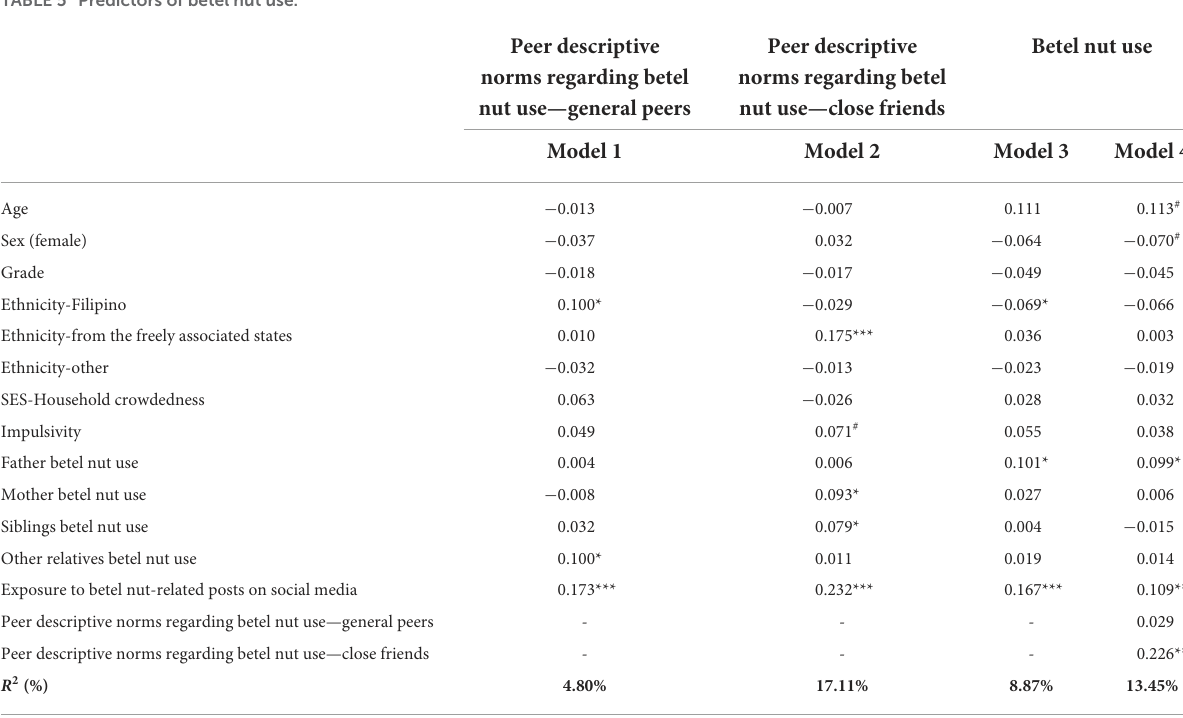
TABLE 5 Predictors of betel nut use.